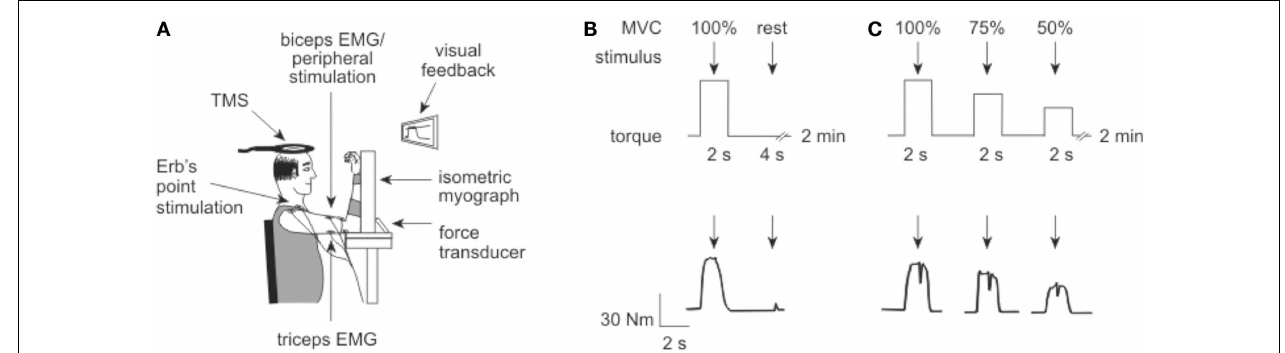
biceps brachii during and after a brief MVC.The protocol is illustrated above, with a torque trace from a participant shown below. (C) To measure voluntary activation in the second protocol,TMS (arrows) was delivered over motor cortex during a 100, 75, and 50% MVC, approximately 4–5s apart. Again, the protocol is illustrated above with a participant’s torque record shown